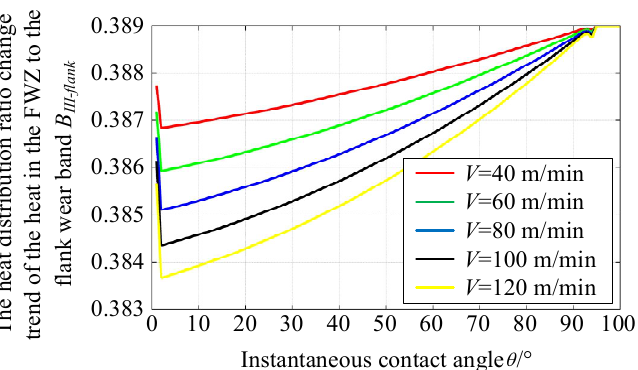
Figure 25. Heat distribution ratio of the heat source in the FWZ to the wear band on the flank of end mills at different milling depths ( V = 40 m/min).